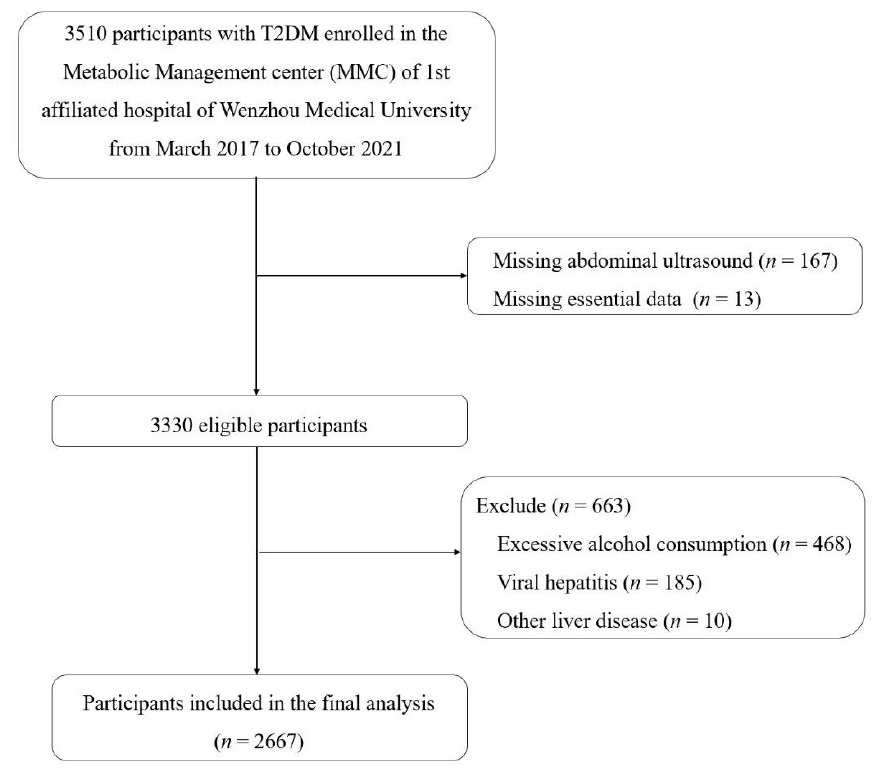
Figure 1. Flow diagram of study participant selection.